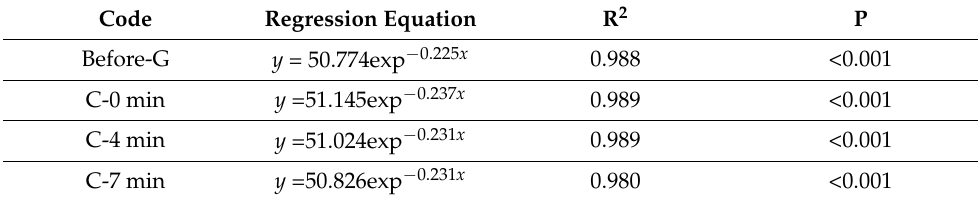
Table 5. Regression analysis of the relationship between AT and thickness in each